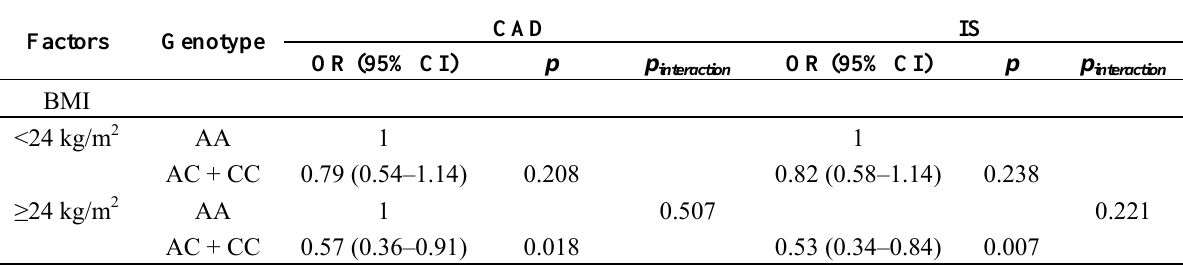
Table 3. The risk of rs1044925 for CAD and IS according to body mass index (BMI), gender, smoking and